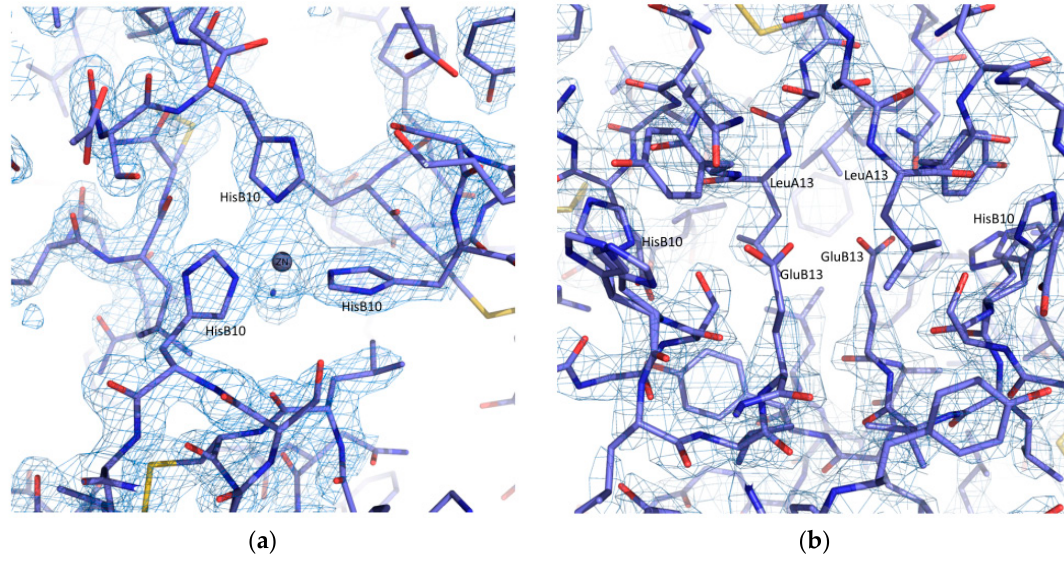
Figure 15. Selected regions of refined structural models and OMIT maps contoured at 1 σ showing ( a ) The arrangement of three HisB10 residuesaround the Zinc ion in rhombohedral symmetry (space group R 3, pH 7.29). ( b ) The arrangement of HisB10 residues in cubic symmetry (space group I 2 1 3, pH 8.56), where the absence of zinc ions is evident. In the cubic phase, HisB10 is flexible occupying 3 conformations as shown in the right panel [91].